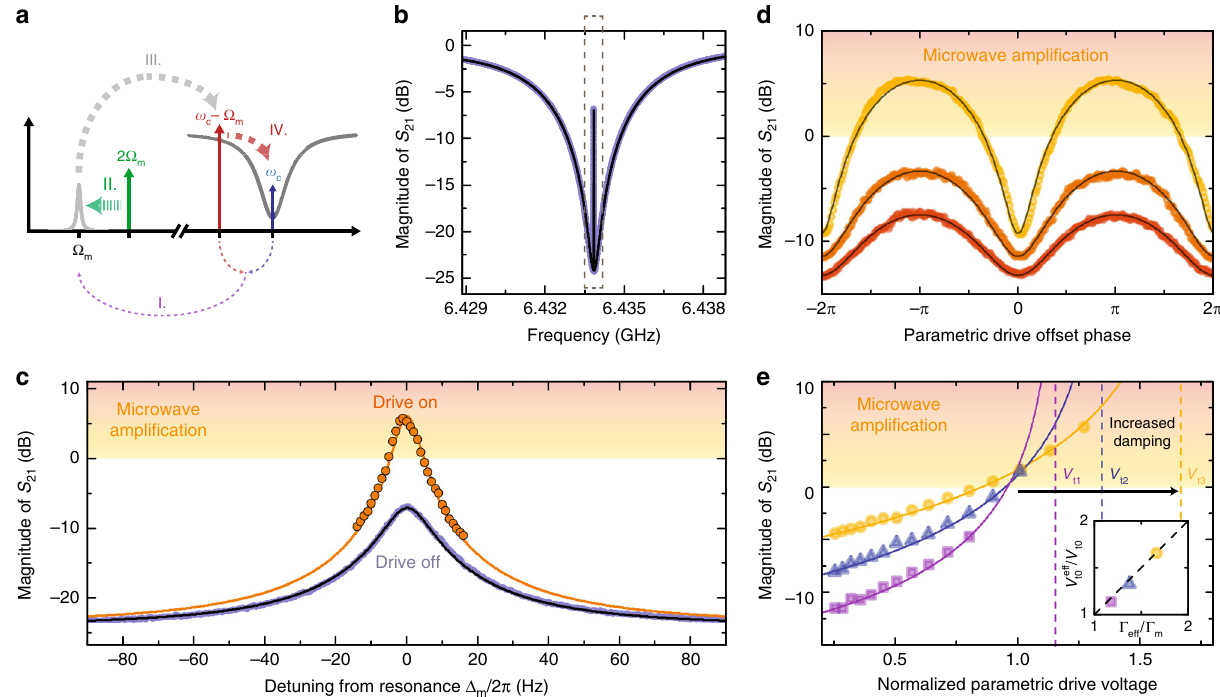
Fig. 4 Phase-sensitive and tunable microwave ampli fi cation by parametric mechanical driving. a Experimental scheme. The cavity is coherently driven on the red sideband ω d = ω c − Ω m . In addition, a small probe tone is swept through the cavity resonance. At the same time, the resonance frequency of the mechanical oscillator is parametrically modulated with 2 Ω . b Optomechanically induced transparency (OMIT) without parametric modulation V 2 Ω = 0. Data are shown in blue, black line is a fi t, the dashed box indicates the zoom-in region shown in panel ( c ). In addition to the data without parametric modulation, we show the highest achieved transmission with parametric driving as orange circles. Close to the mechanical resonance we observe intracavity gain of the probe signal up to ~14 dB and net transmission gain of ~7 dB. The orange line shows a theoretical curve calculated with independently obtained parameters. The schematic in ( a ) visualizes the ampli fi cation mechanism. By the beating of the two cavity tones, energy from the cavity fi eld is converted into mechanical motion, which is ampli fi ed by parametric modulation. The hereby increased energy is upconverted back to the probe tone frequency as sideband of the red-detuned drive tone. d The microwave gain is phase-sensitive; it depends on the phase between the parametric modulation and the intracavity amplitude beating. The three data sets (black lines are fi ts) show the gain for different detunings from ω p − ω d = Ω m (0 Hz, 2 π ⋅ 7 Hz and 2 π ⋅ 12 Hz). e Probe-tone gain vs. parametric drive voltage for three different red-sideband drive powers. The parametric drive voltage is normalized to its value obtained in Fig. 2 using a resonant drive for amplitude detection. Lines are calculations based on independently extracted parameters. The parametric instability threshold, indicated by dashed vertical lines, is shifted to higher values with increasing red-sideband drive power, partly due to optical damping, partly due to a power-dependent intrinsic mechanical damping rate. The inset shows the extracted threshold voltage vs. effective mechanical linewidth and as dashed line the theoretical prediction. The cooperativity for ( b − d ) is C (cid:5) 0 : 5 and C (cid:5) 0 : 16 ; 0 : 28 ; 0 : 5 for ( e